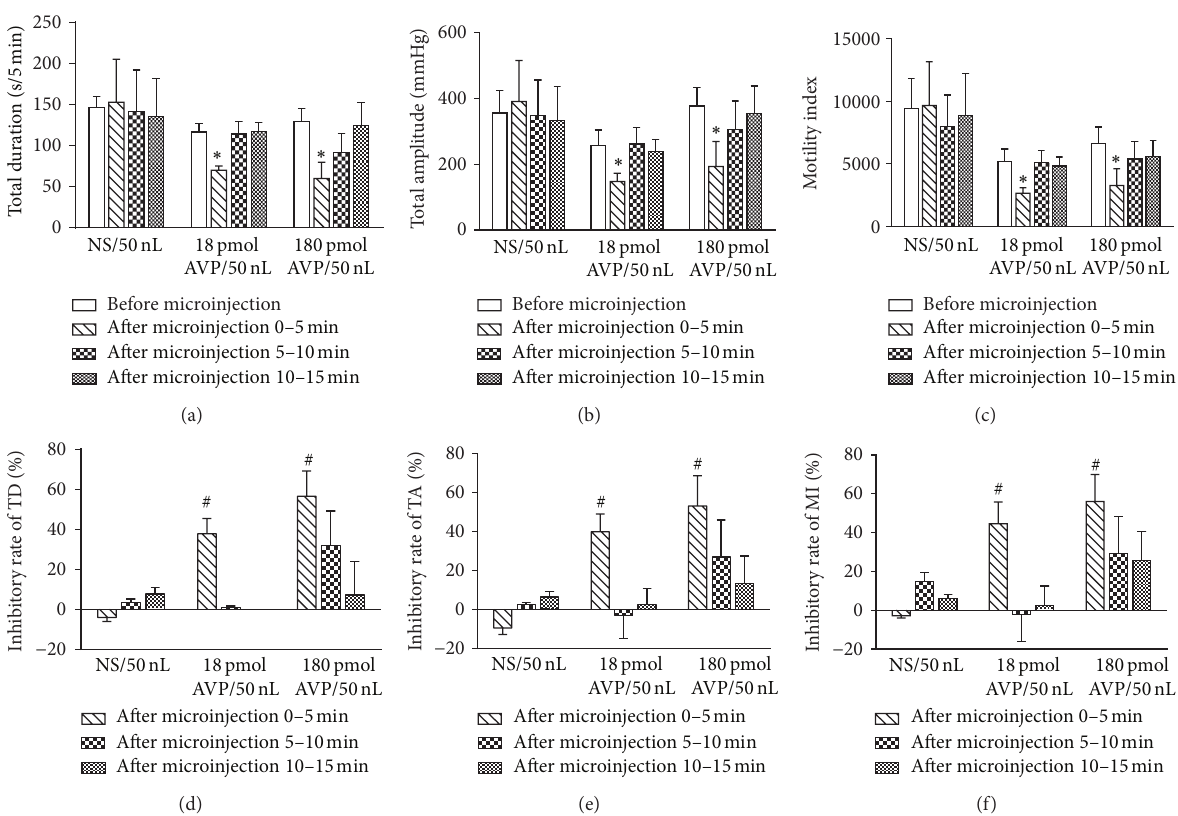
observed in group 3, in which AVP was substituted for NS ( 𝑃 > 0.05